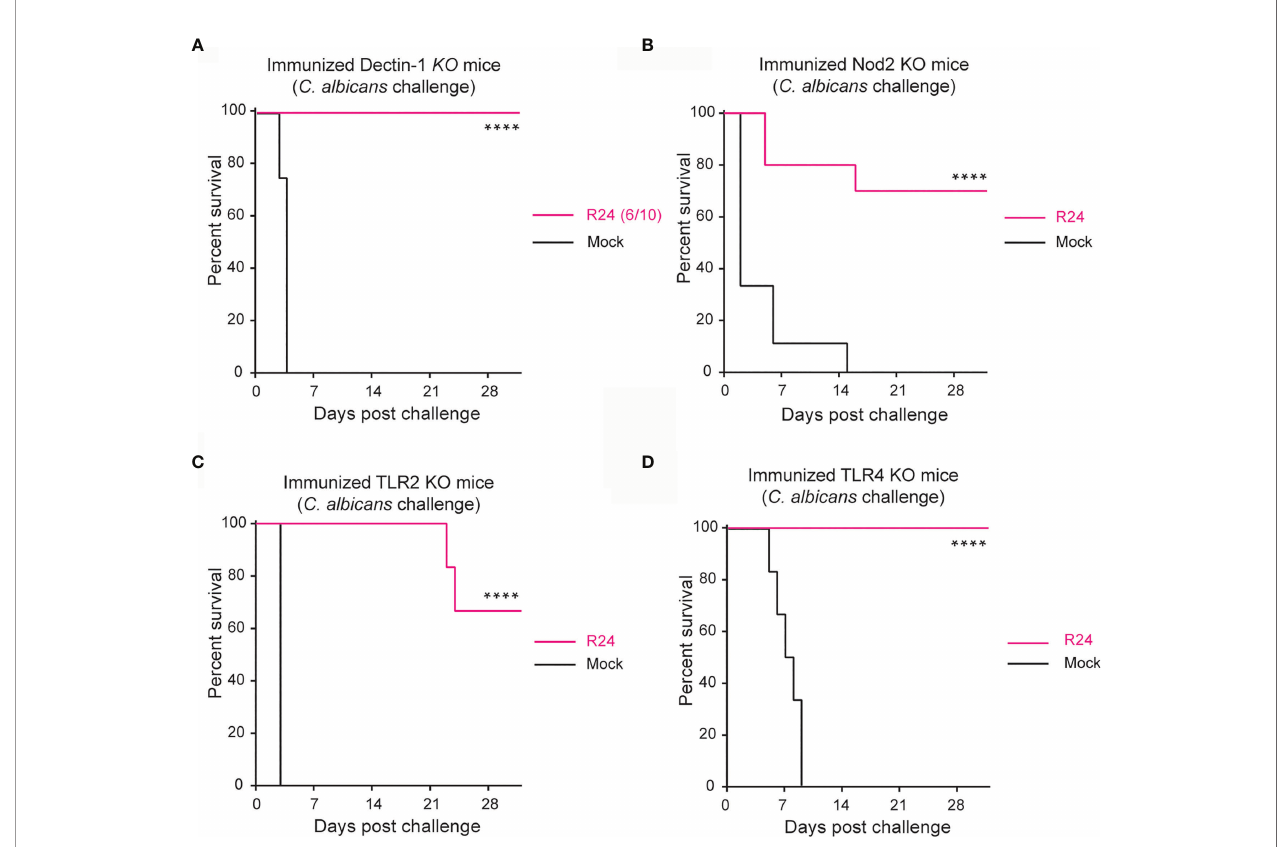
FIGURE 1 | Protection against systemic candidiasis using the evolved strain is not dependent on Dectin-1, NOD2, TLR2 or TLR4. Survival of Dectin-1 (A) , NOD2 (B) , TLR2 (C) and TLR4 (D) KO mice immunized with 5x10 5 CFUs of the gut-evolved strain R24 were challenged at day 14 post-immunization with a lethal dose of the WT C. albicans (SC5314) (5x10 5 CFUs). n = 10 mice/group. Log-rank survival test was performed in Prism v9. **** P <